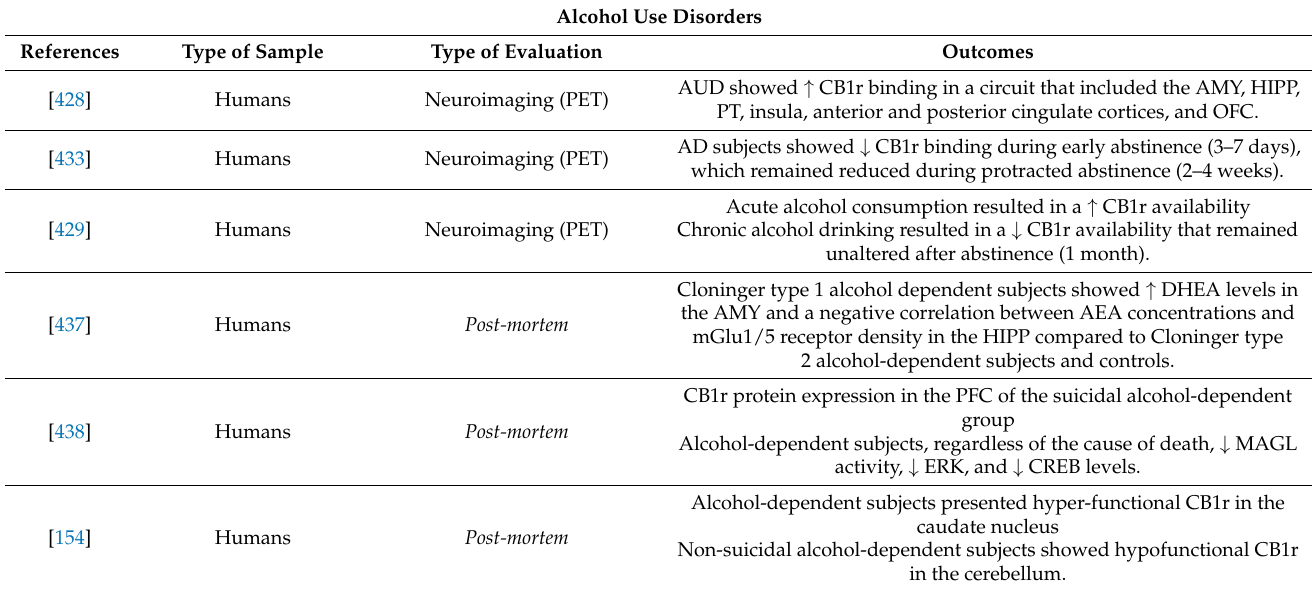
Table 2. Summary of main findings regarding the alterations of the ECS components in animals and human studies in Alcohol Use